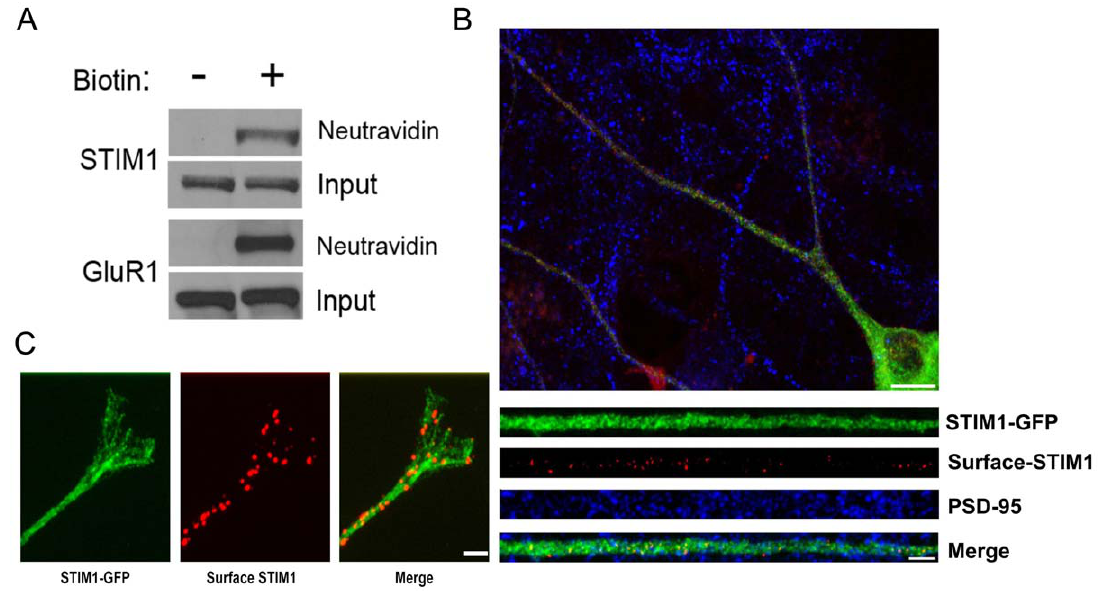
Figure 2. STIM1 is present at the surface of hippocampal neurons. (A) Cell surface STIM1 protein populations were examined biochemically by labeling cortical neurons (DIV . 21) with NHS-LC-biotin followed by precipitation of the resulting lysates with neutravadin biotin binding beads. Precipitates were resolved by SDS-PAGE and analyzed via western blot with a -STIM1 (top) or a -GluR1 (bottom) antibodies. Representative blots depicted from 3 independent experiments. (B) Rat hippocampal neurons (DIV 21 and 4) were infected with Sindbis STIM1-GFP virion. Expression was allowed to continue for 12 hours. The cells were then live-labeled with a -GFP-Alexa 594 conjugated antibodies (red) prior to fixation, permeabilization, and immunolabeling with a -PSD-95 antibodies (blue). As depicted in (B–C), STIM1-GFP is present on the surface of dendrites and growth cones. Representative images depicted from . 40 images acquired. Whole cell scale bar =20 m m; dendrite scale bar =10 m m; Growth cone scale bar =5 m m.